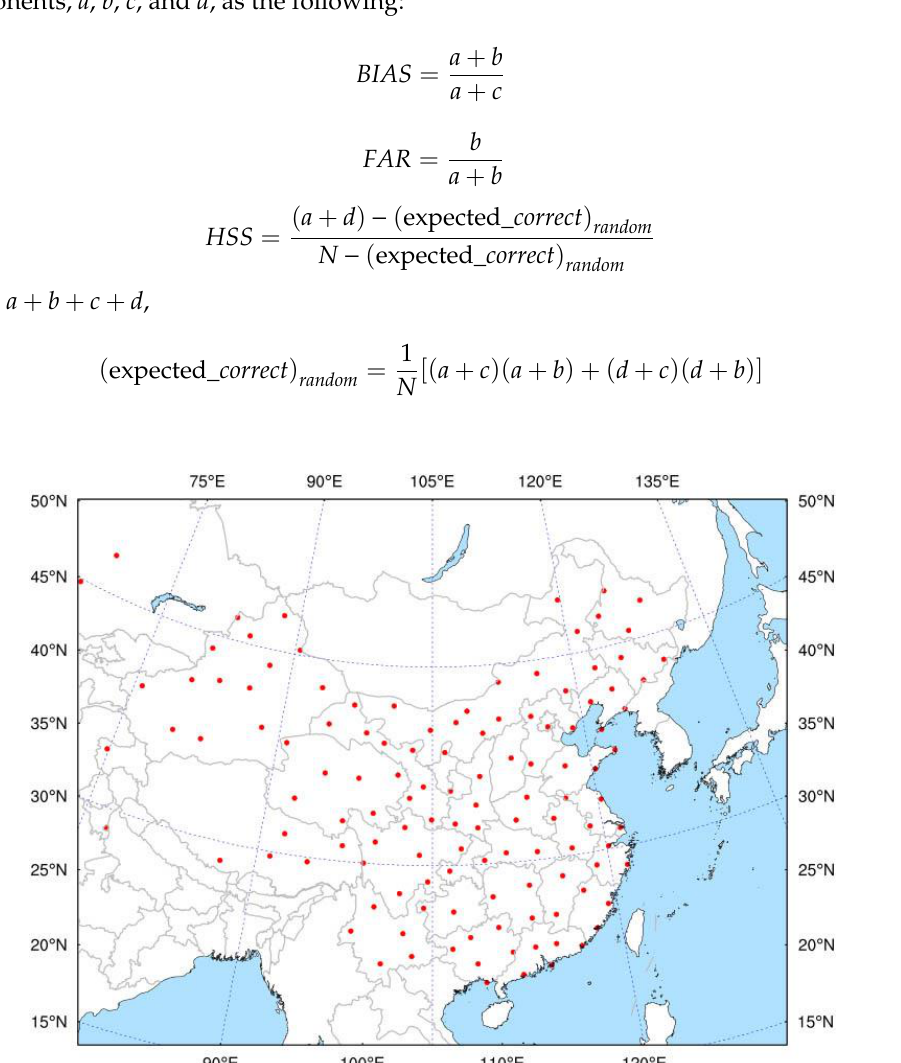
Figure 2. Conventional sounding observations in Domain 1 of the RMAPS-ST used for verification and evaluation in the data assimilation experiments. Table 2. Contingency